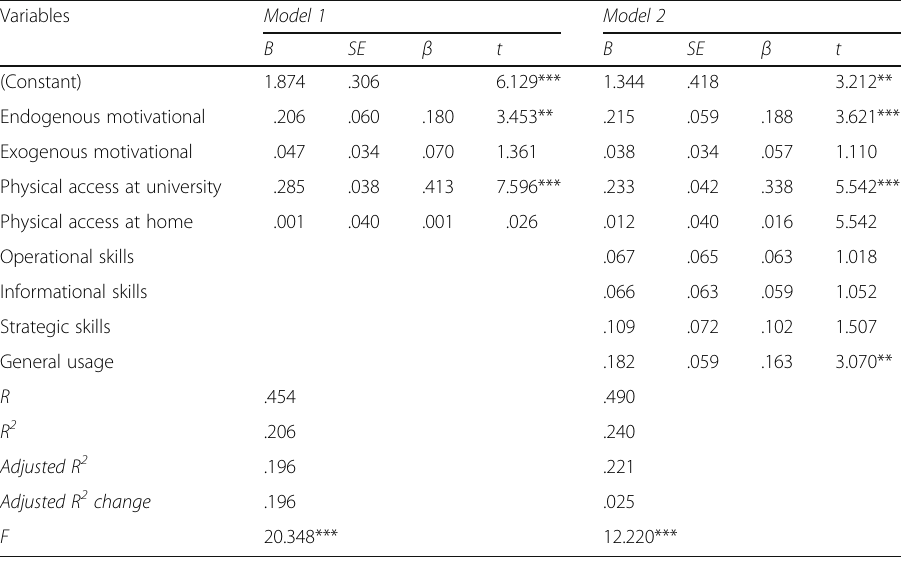
Table 4 Hierarchical regression results predicting instructional usage access ( N = 317)